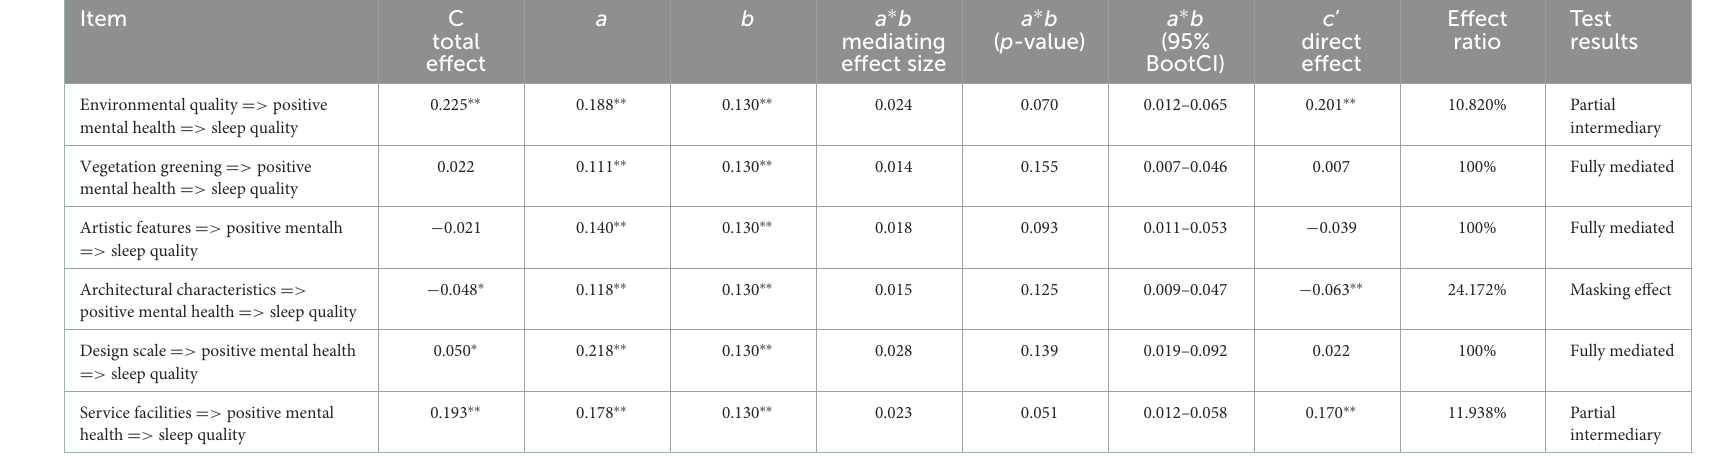
TABLE 10 Summary of test results of physical environment through mental health mediation. Item